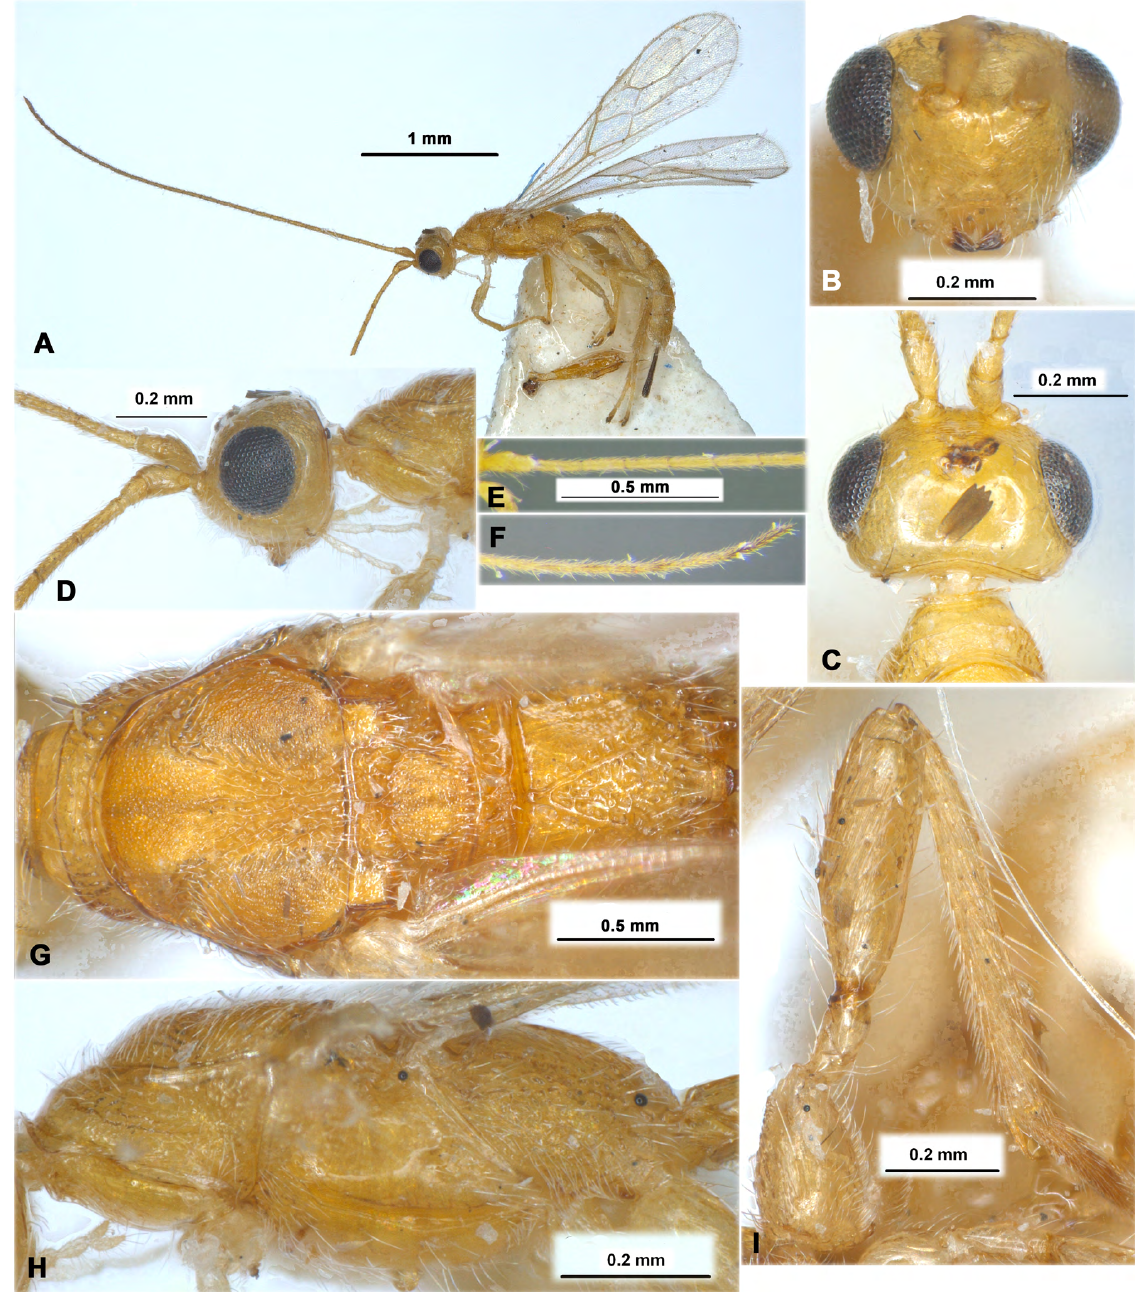
Fig. 42. Rhaconotinus ( Hexarhaconotinus ) hexatermus (Belokobylskij, 1988) comb. nov., ♀, holotype, ZISP. A . Habitus, lateral view. B . Head, front view. C . Head, dorsal view. D . Head, lateral view. E . Basal segments of antenna. F . Apical segments of antenna. G . Mesosoma, dorsal view. H . Mesosoma, lateral view. I . Hind